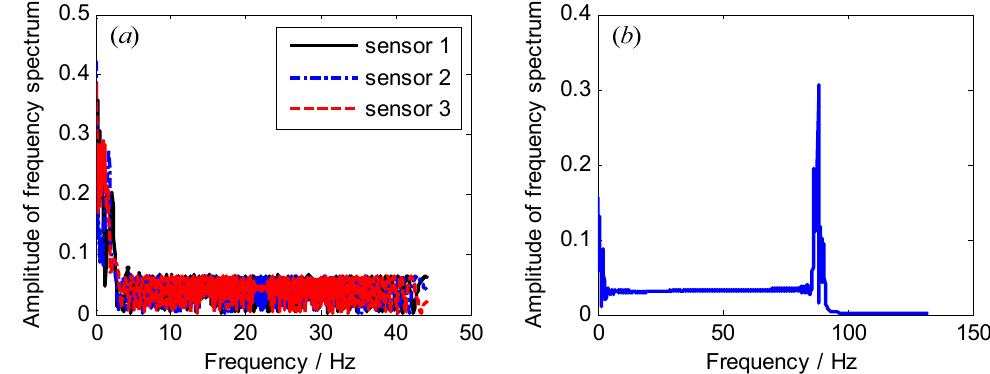
Figure 6. Frequency spectrums of sampled signals from both ( a ) each BTT sensor and ( b ) three BTT sensors.